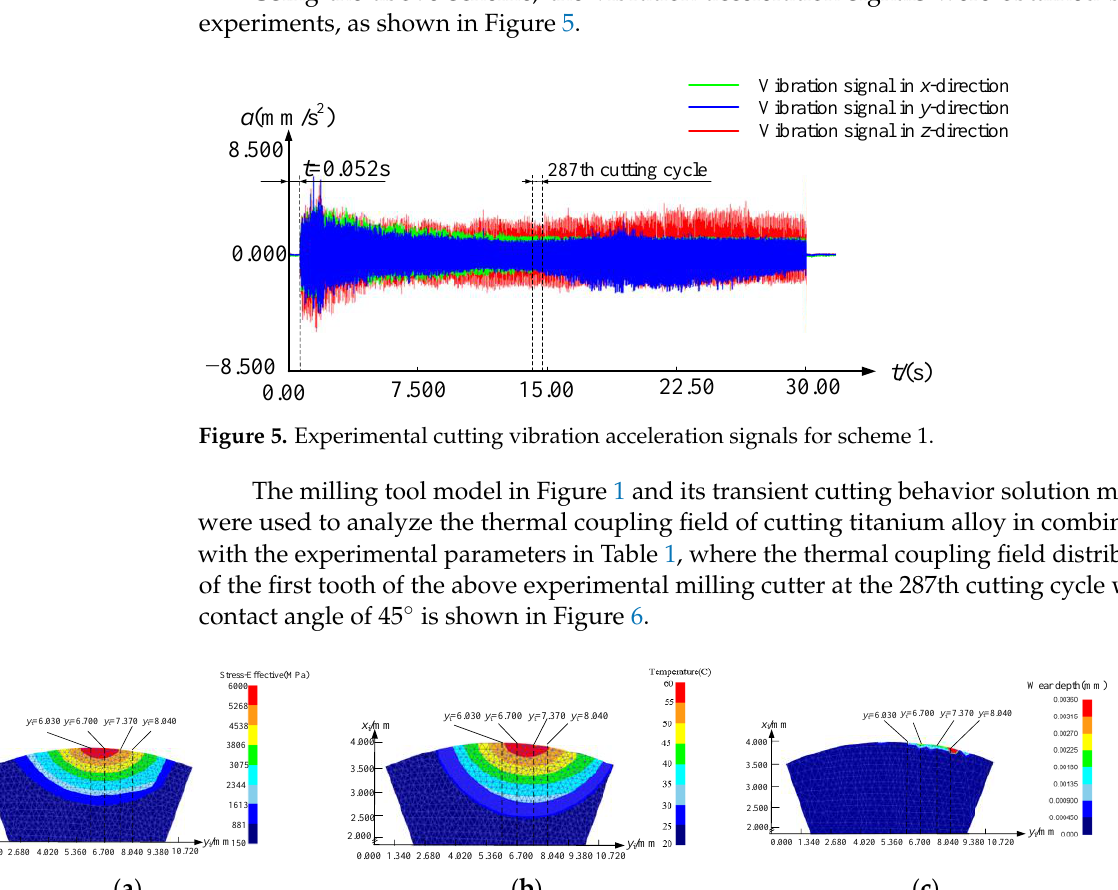
Table 2. Experiment scheme 1.